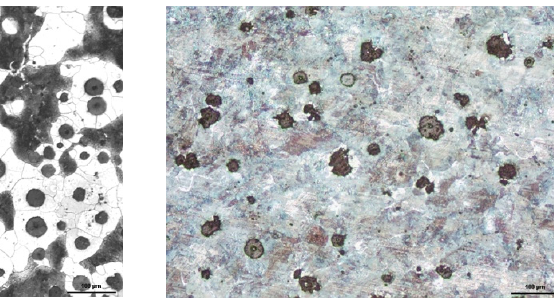
Figure 5: DCI EN GJS700-2 microstructure (100% pearlite).